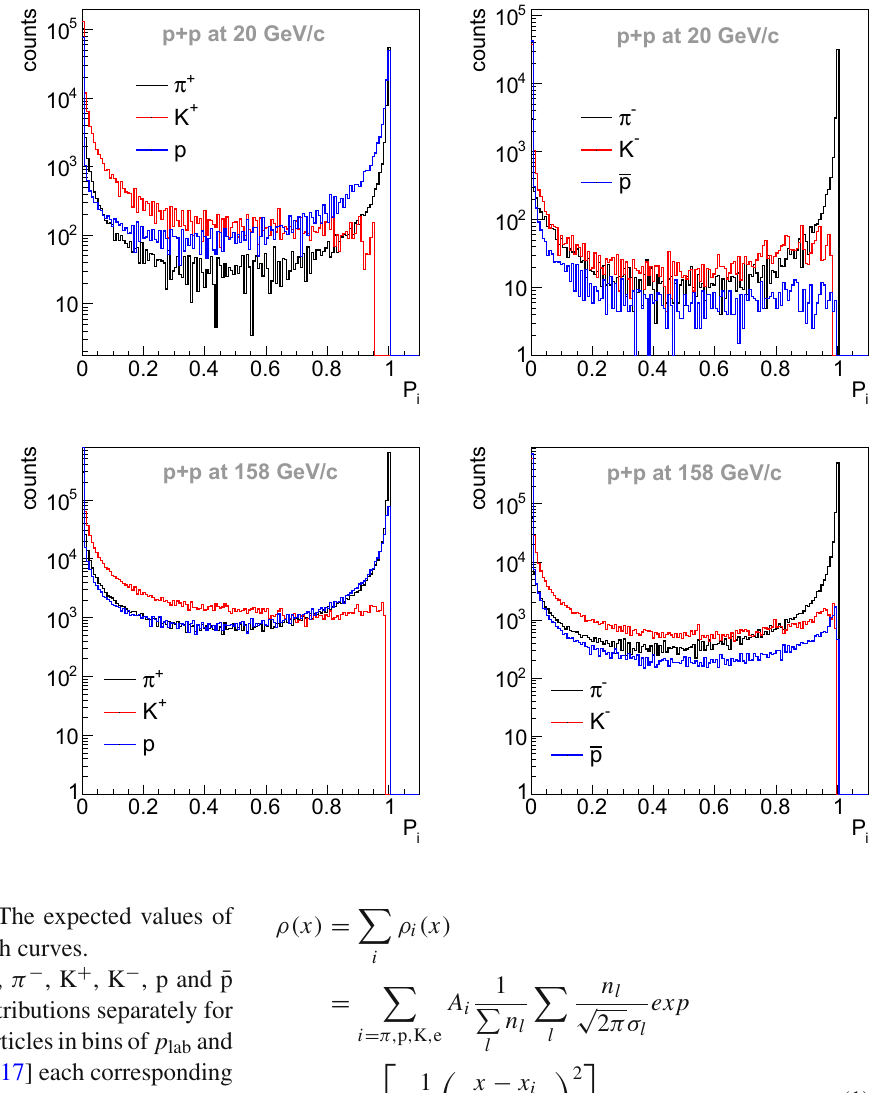
Fig. 10 Probability of a track being a pion, kaon, proton for positively (left panels) and negatively (right panels) charged tracks from d E / d x measurements in p + p interactions at 20 and 158 GeV /